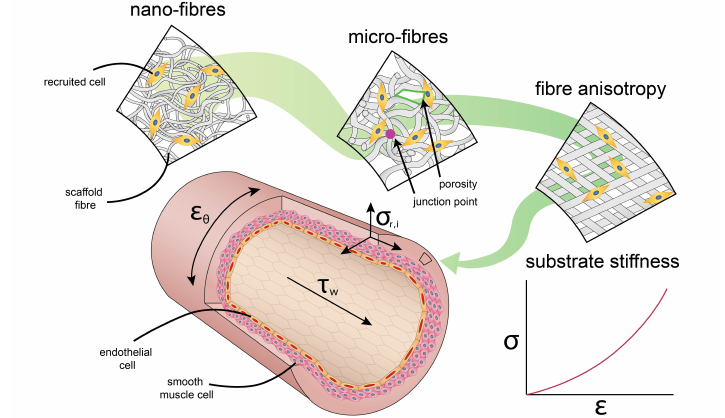
Figure 4. Passive and active cues in the context of scaffold design parameters and cardiovascular systems. Passive cues define the physical environment in which the cells reside, such as fibre diameter (nano-fibres vs. micro-fibres), topography (isotropic vs. anisotropic), and substrate stiffness. Active cues directly impose mechanical stimulations to the cell, such as shear stress ( τ w ), cyclic strain ( ε θ ), and residual stress ( σ r , i